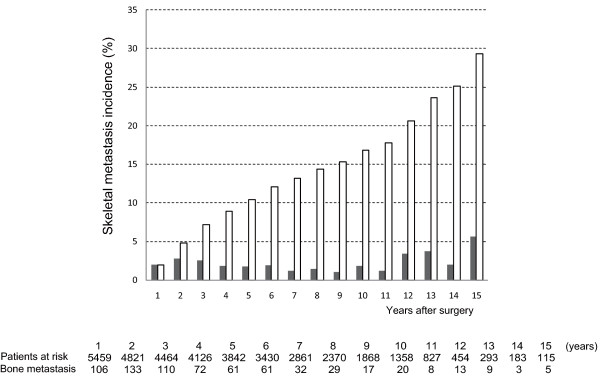
Annual and Cumulative Incidence of Bone Metastasis for All Breast Cancer Patients. Annual (shaded bar) and cumulative (open bar) incidence of bone metastasis is given for all patients enrolled, including those with non-invasive breast cancer. The numbers of patients at risk and with bone metastasis events are shown in the lower column.